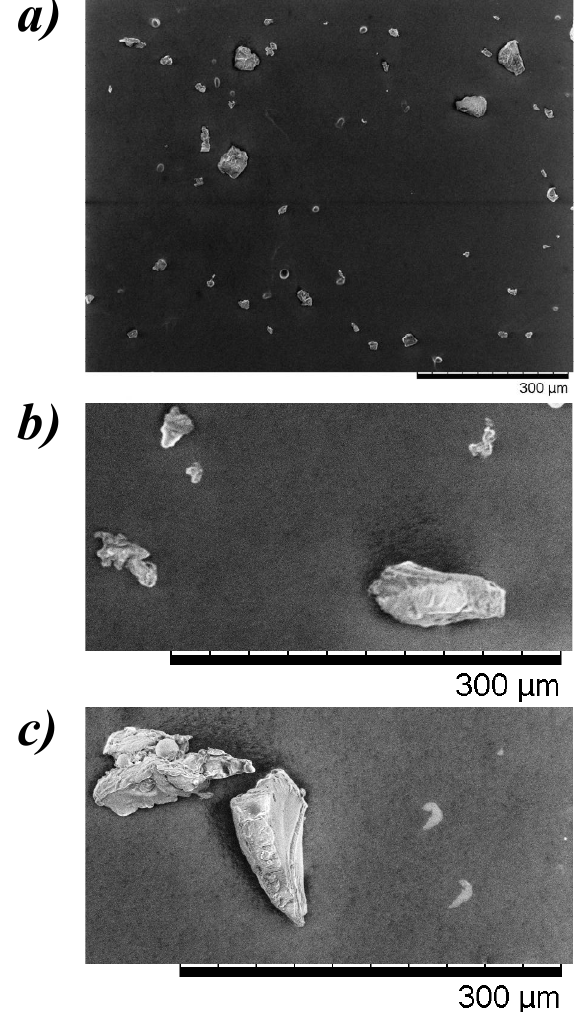
Figure 1. SEM images of Polyamide 6 (SINTERLINE ® ) particles: ( a ) many dispersed particles; ( b ) and ( c ) show details of some particles.